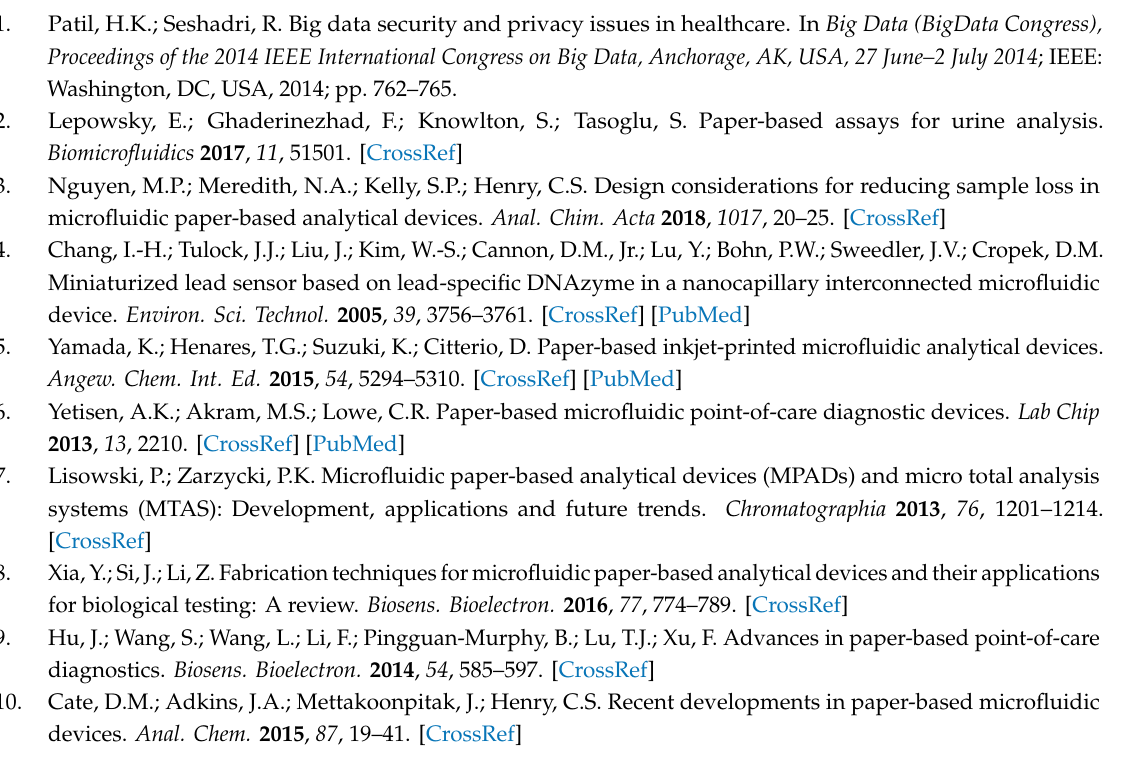
Figure S1: Flow test of various channel sizes, Figure S2: The front and back of the 500 µ m channel from the 250–700 µ m channel flow testing, Figure S3: Images of the equal channel flow testing, Figure S4: Plotting speed in units of mm / s vs percentage; linear velocity (mm / s) was calculated by measuring the time needed for plotting a 25 cm line, Table S1: Comparison among analog fabrication methods, Table S2: Comparison among digital fabrication